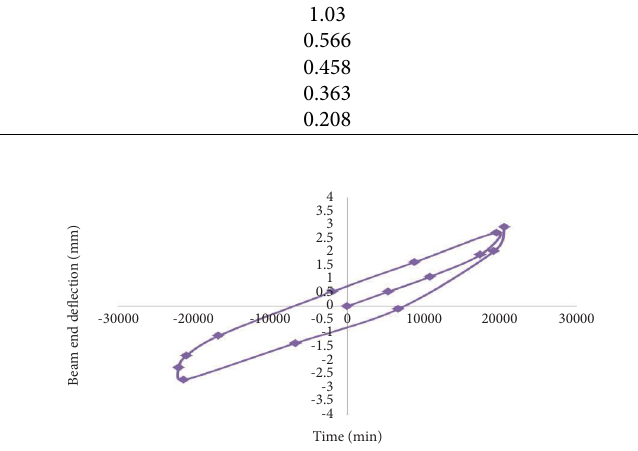
Figure 19: Hysteresis loop for static